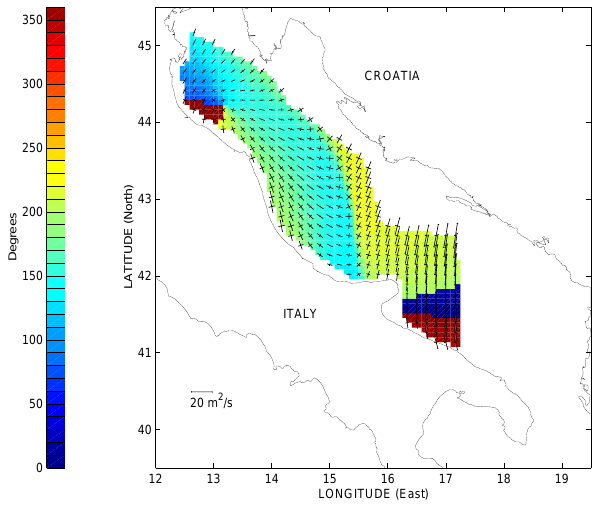
Fig. 9. Same as Fig. 8, but for the K1 tidal component.